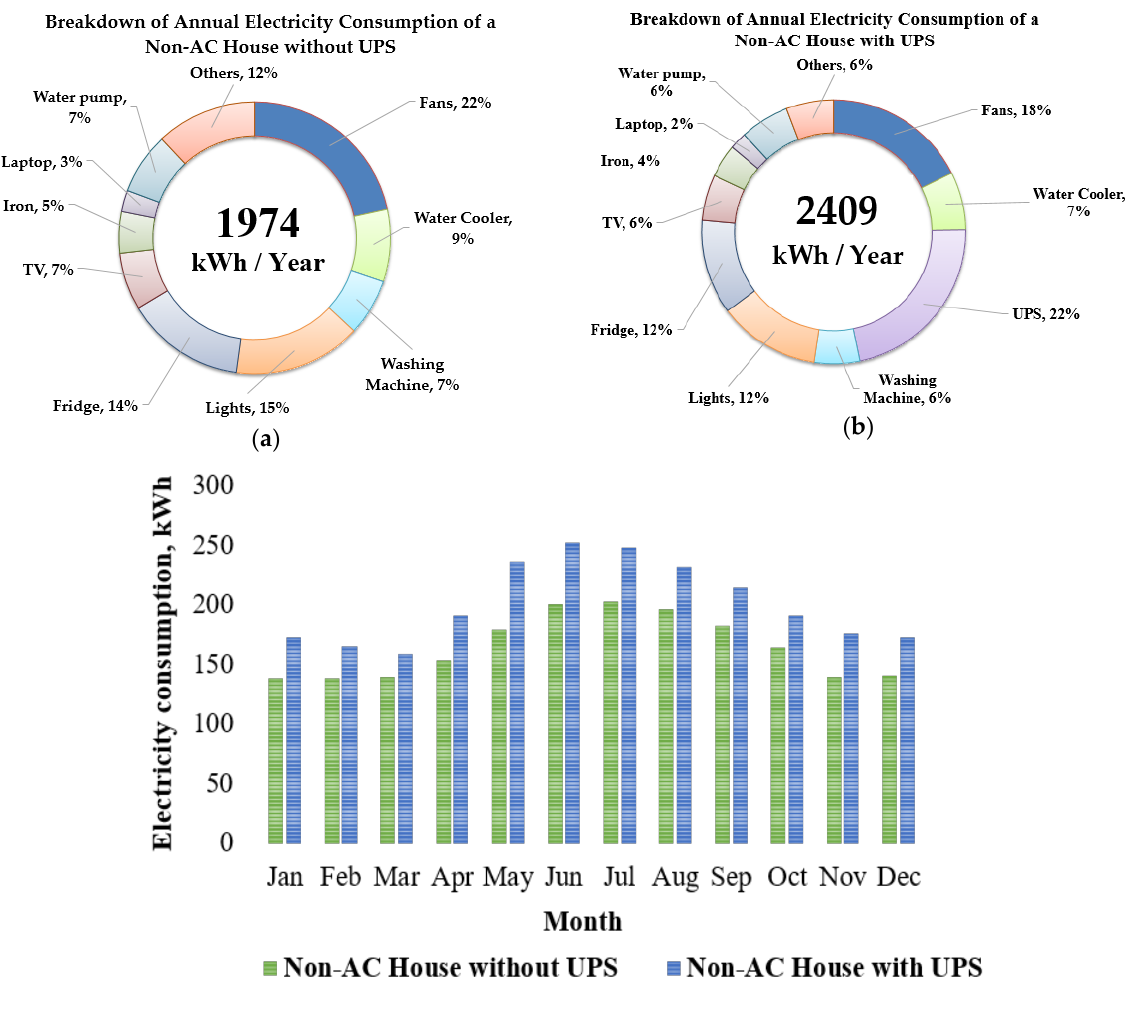
Figure 8. ( a ) Breakdown of Annual Electricity Consumption of a Non-AC House without UPS, ( b ) Breakdown of Annual Electricity Consumption of a Non-AC House with UPS ( c ) Monthly electricity consumption of non-AC houses with and without UPS.